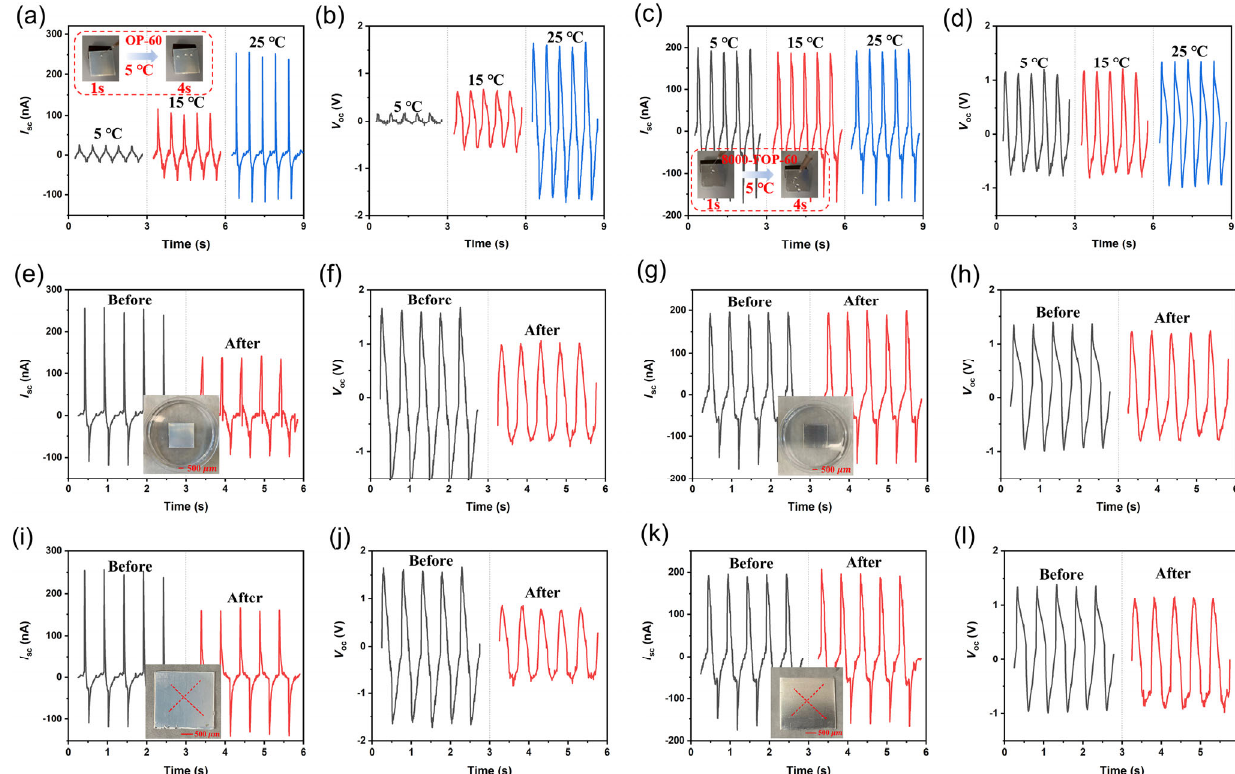
Fig. 6 Stability and durability tests of the hydrophobic/SLIPSs TENG devices. (a) I sc and (b) V oc of the OP-60 TENG at different temperature, (c) I sc and (d) V oc of the 8000-FOP-60 SLIPSs TENG at different temperature, the insets in (a) and (c) were the sliding process of droplets on the surfaces of OP-60 and 8000-FOP-60 at about 5 °C with inclination angle of 30°, respectively. (e) I sc and (f) V oc of the OP-60 TENG before and after being immersed in water for 48 h, (g) I sc and (h) V oc of the 8000-FOP-60 TENG before and after being immersed in water for 48 h, the insets in (e) and (g) were the images of the samples of OP-60 and 8000-FOP-60 that be immersed in water, respectively. (i) I sc and (j) V oc of the OP-60 TENG before and after the surfaces were destroyed by scratches, (k) I sc and (l) V oc of the 8000-FOP-60 SLIPSs TENG before and after the surfaces were destroyed by scratches, the insets in (i) and (k) were the images of the surfaces of OP-60 and 8000-FOP-60 were destroyed by scratches,